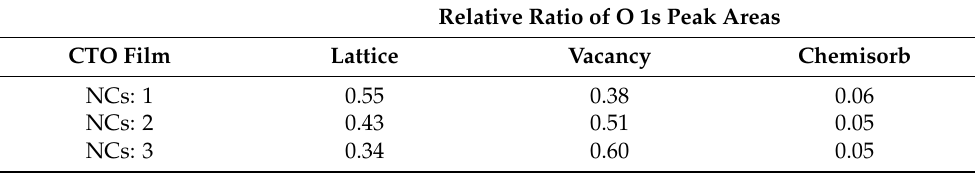
Figure 6. ( a ) UV–vis absorption spectra of NCs: 1, NCs: 2 and NCs: 3, ( b ) optical energy bandgap of NCs: 1, NCs: 2 and NCs: 3. Table 1. Relative ratio of the O 1s peak area extracted from